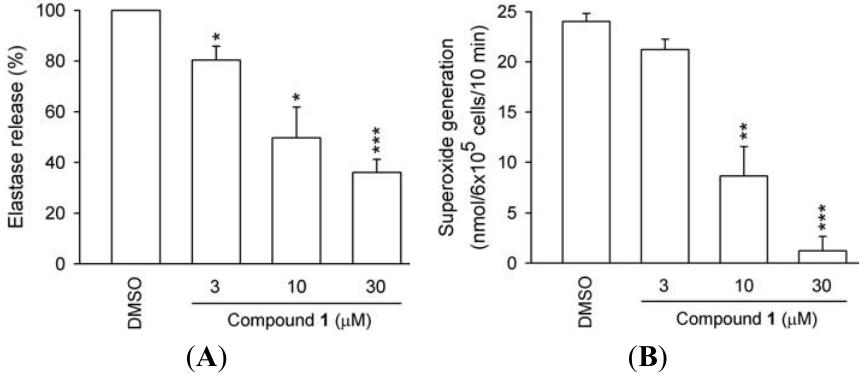
Figure 3. Concentration-dependent effects of compound 1 on O 2• − production and elastase release in human neutrophils. Human neutrophils were preincubated with DMSO